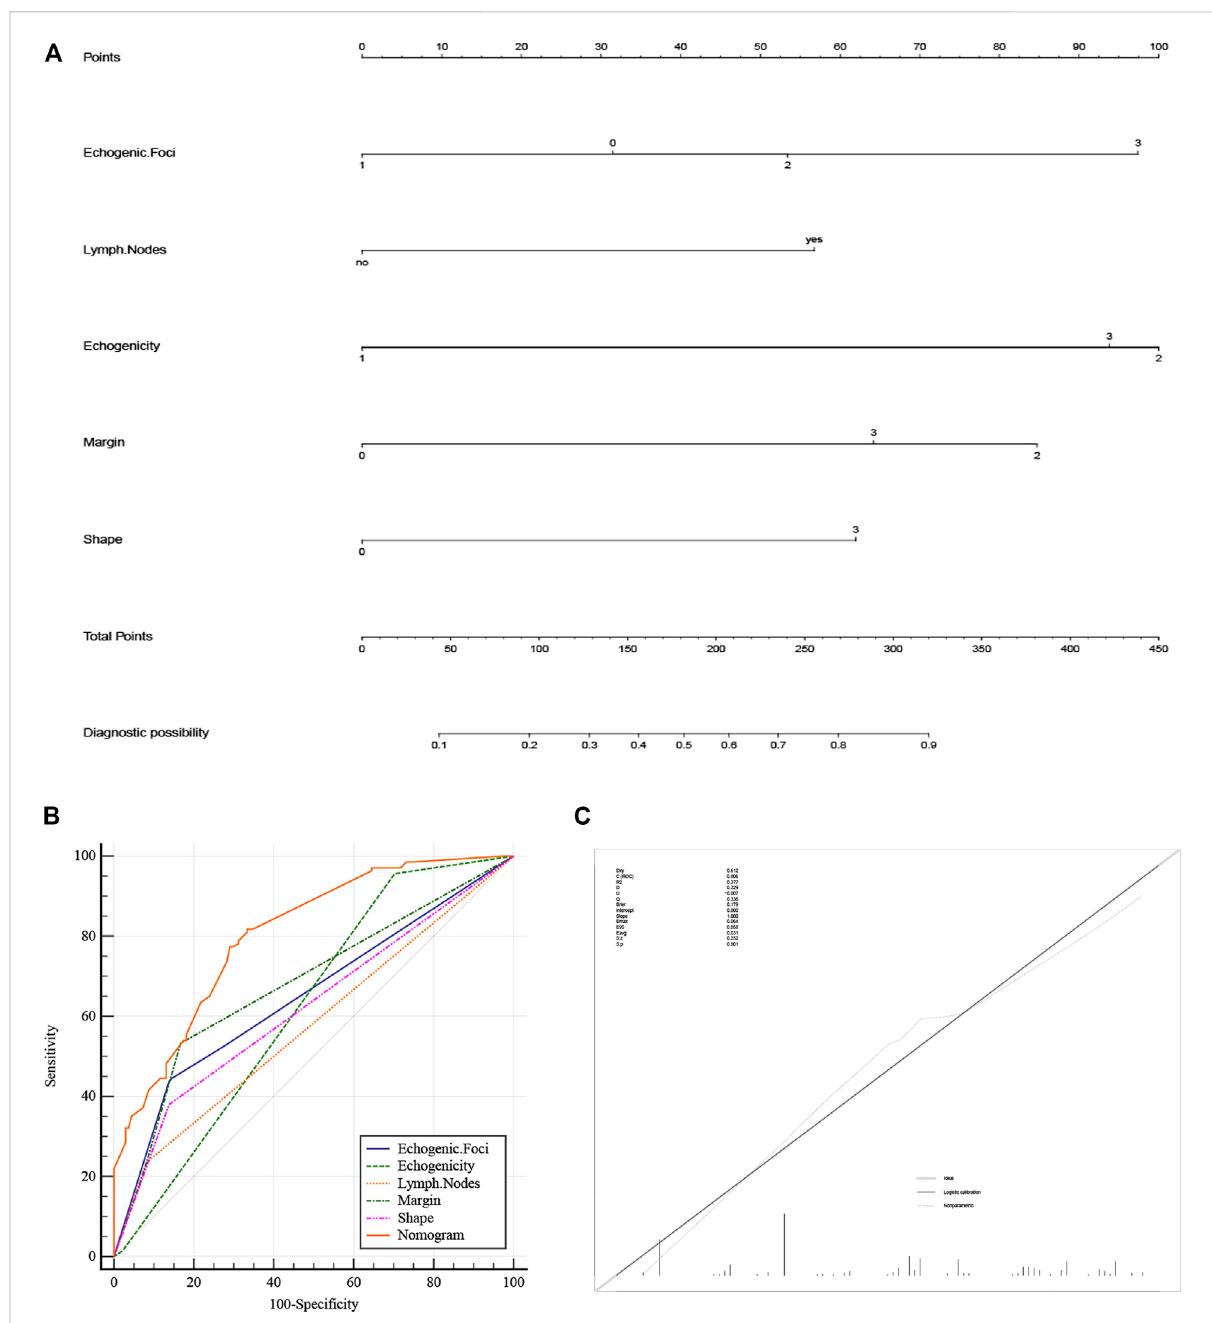
FIGURE 2 (A) Nomogram of the BRAF gene diagnosis. The corresponding node is selected on each variable axis and a straight line is plotted upwards to determine the score for each node. The sum of these numbers is positioned at the corresponding position on the total point axis and this line is plotteddownwardstoobtaintheriskofBRAFgenemutation. (B) Themodel ’ sROCcurve. (C) Calibrationplotshowingthenomogrampredictionand theactualobservation.(Themeaningsrepresentedbyeachnodeofstrongecho,echo,edgeandshapearethesameasTable1).ROC,Receiver Operator